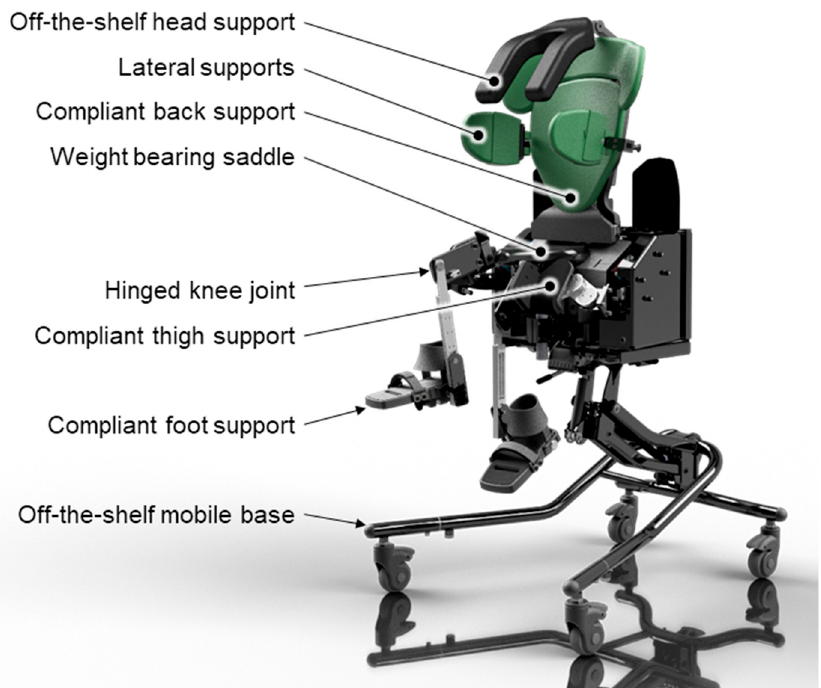
Figure 1. A computer model of the KiTE seat to be used for the study, showing the dynamic foot, thigh and back supports. The seat is mounted on a standard mobile base as used in classrooms and domestic environments.